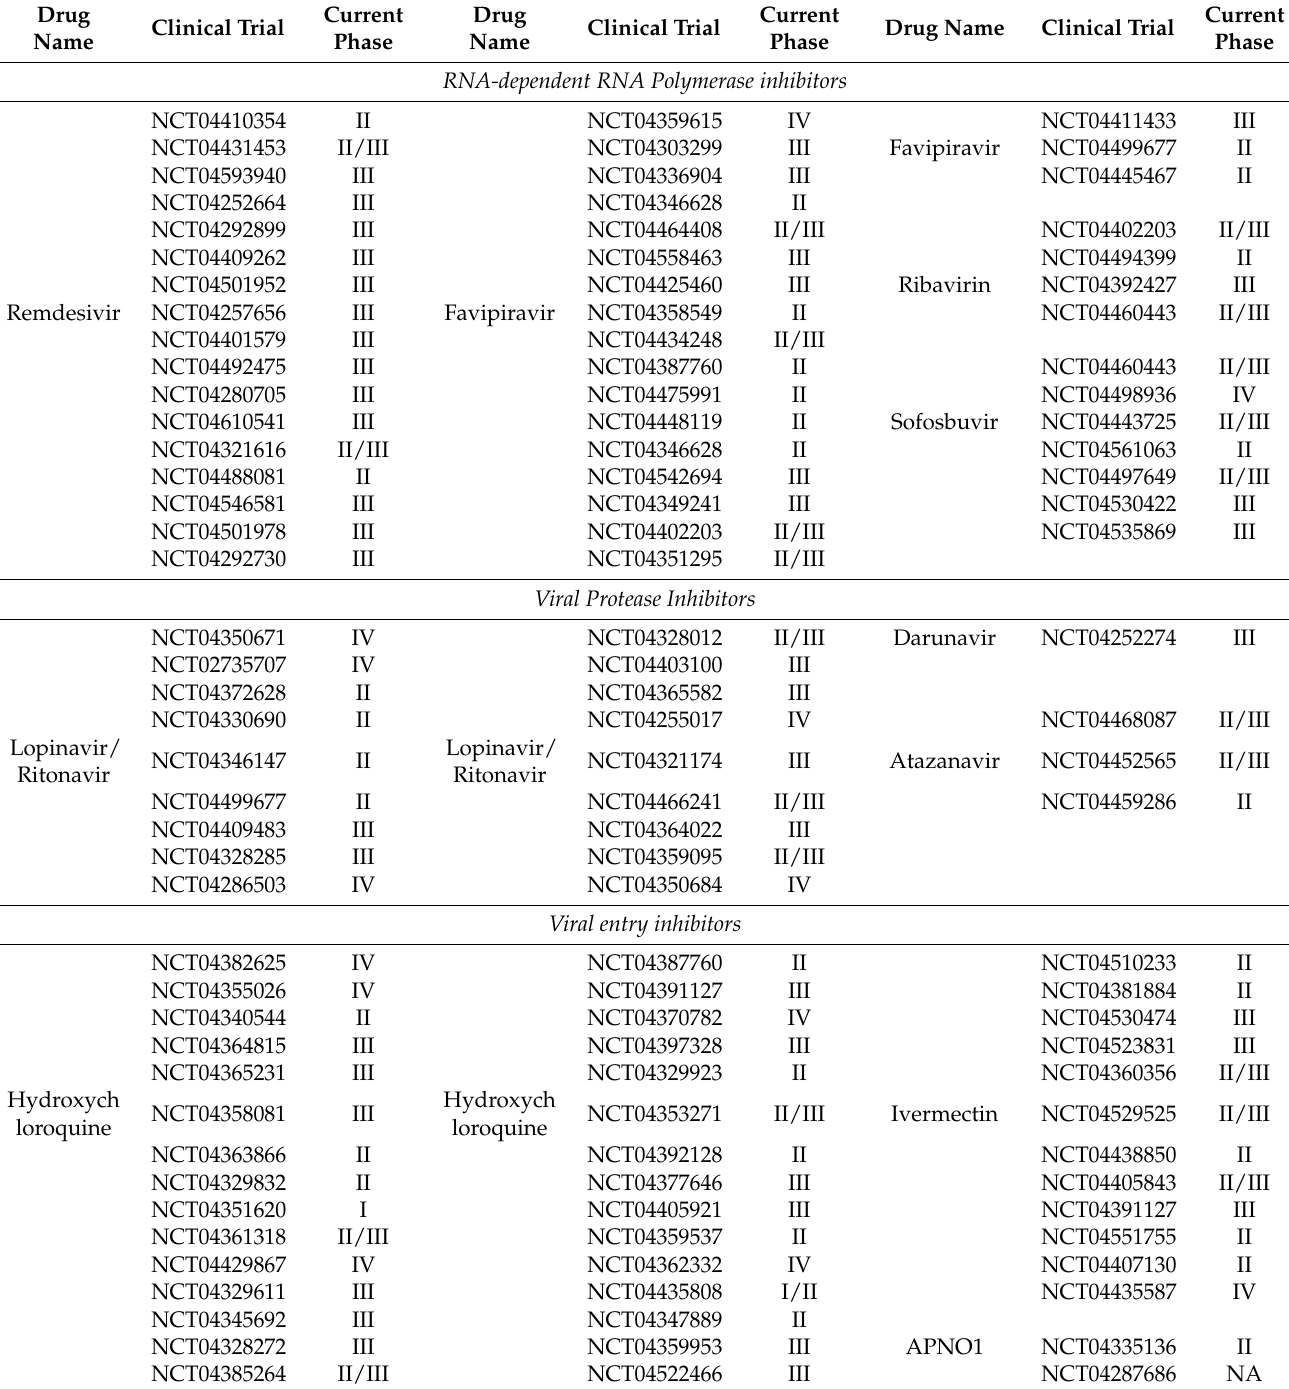
Table 1. Therapeutics and vaccines under development for